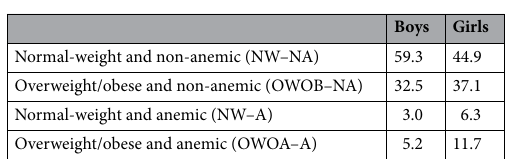
Table 3. Classification of subjects (%) with anemia and weight status.